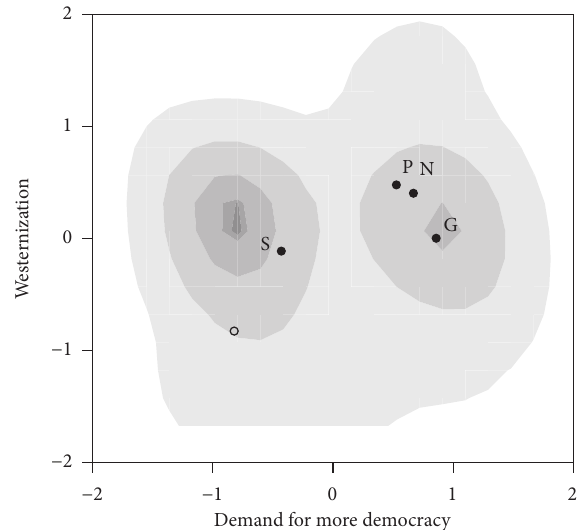
Figure 10: Voter distribution and candidate positions in the 2008 Georgian